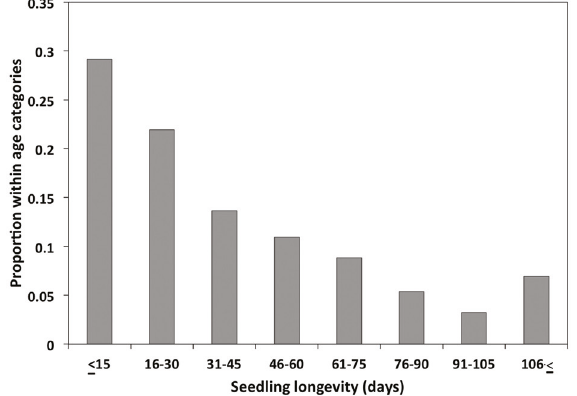
Figure 2. The proportion of the 374 Serianthes nelsonii seedlings that emerged in 2013 within 15-day age interval categories.